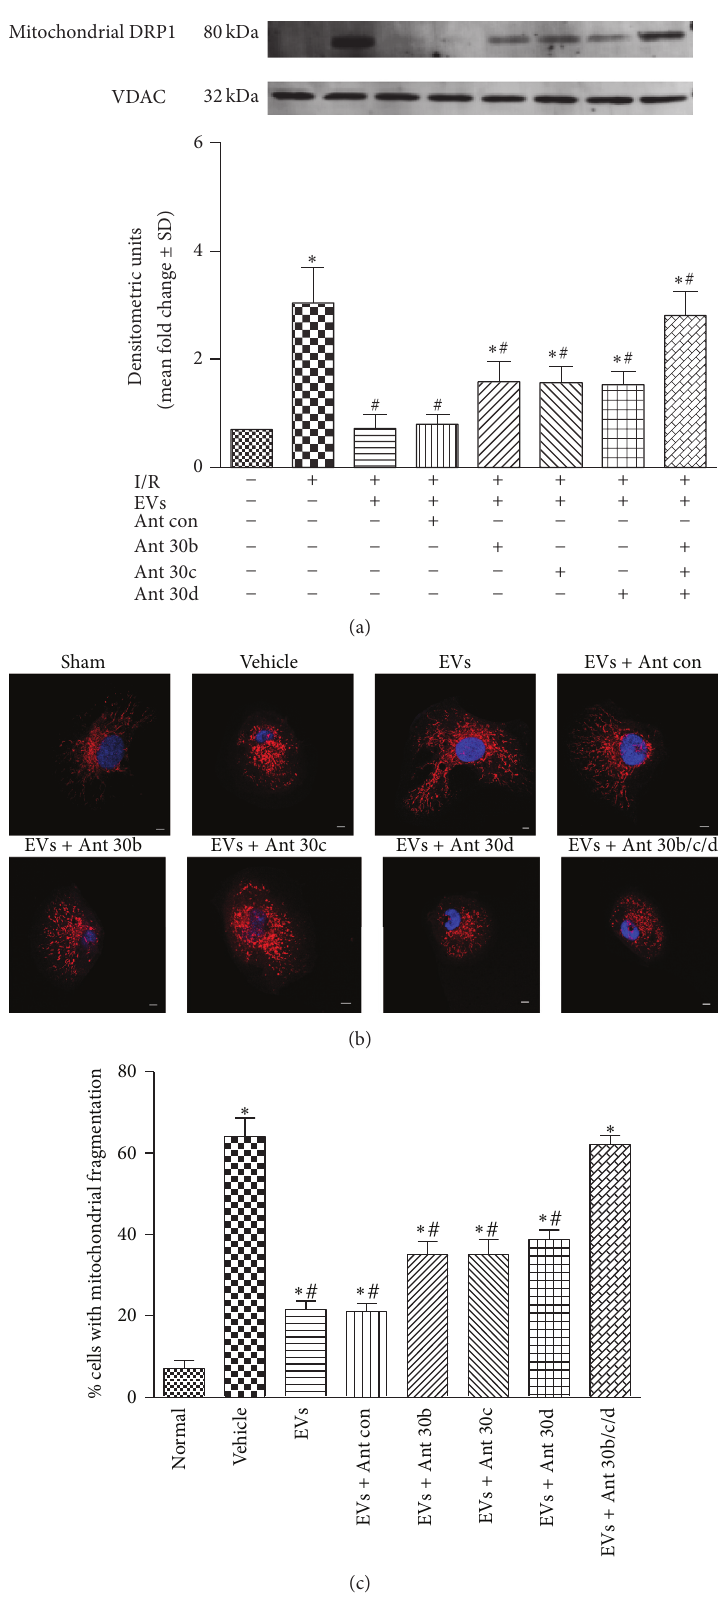
Figure 3: EVs-derived miR-30 members regulate mitochondrial fission through DRP1. (a) Mitochondrial DRP1 expression in kidney tissues in different experimental conditions, including sham, vehicle, EVs, and miR-30b/c/d antagomir-treated EVs group. VDAC antibody served as aloadingcontrol.(b)Themorphologicalalterationsofmitochondriainrenaltubularepithelialcellstreatedinthesegroups.(c)Thepercentage of cells undergoing mitochondrial fission. Data in (a) and (c) are presented as mean ± SD; 𝑛 = 6 ; ∗ 𝑃 < 0.05 , versus sham; # 𝑃 < 0.05 , versus